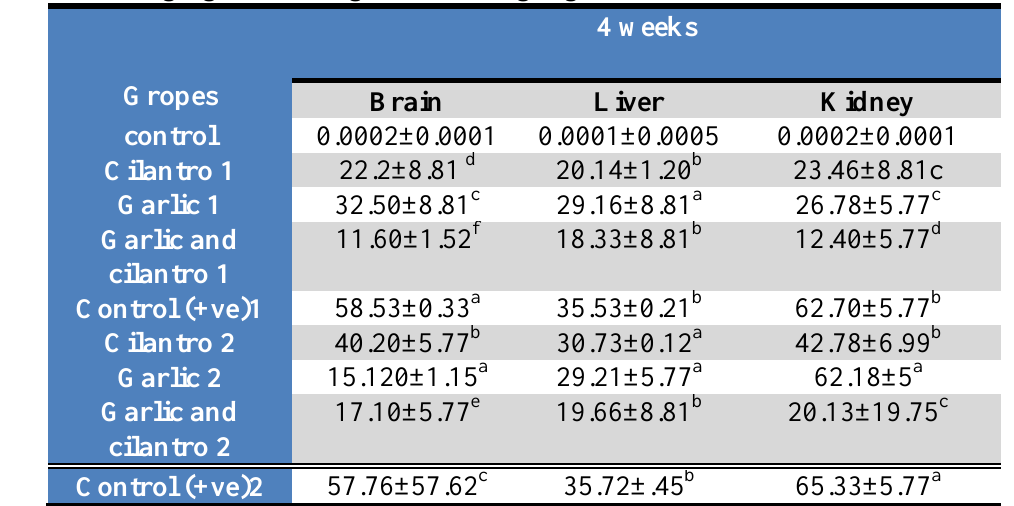
Table (3):Residual of mercuric chloride in rats organs which treated orally with extracts of cilantro (50mg/kg BW) and garlic (100 mg /kg BW) for (4 weeks) .